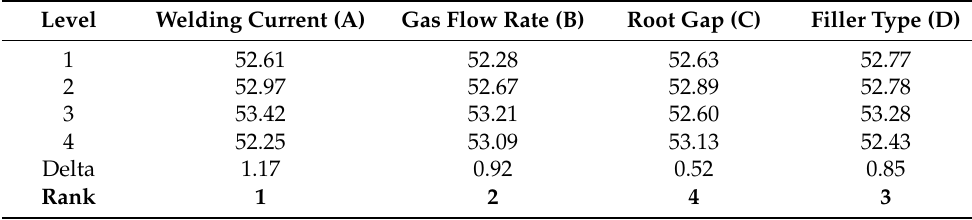
Table 9. Response table for signal-to-noise ratios for Tensile Strength (larger is